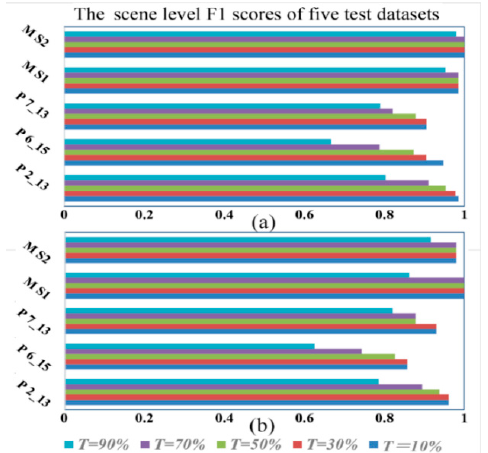
Figure 8. The scene level F 1 scores of the five test images. ( a ) The accuracies of the method CNN_ACM_1, ( b ) the accuracies of the method CNN_ACM_2. The abbreviation of P denotes Potsdam, the abbreviation of M for Marion, T for the overlapping threshold.